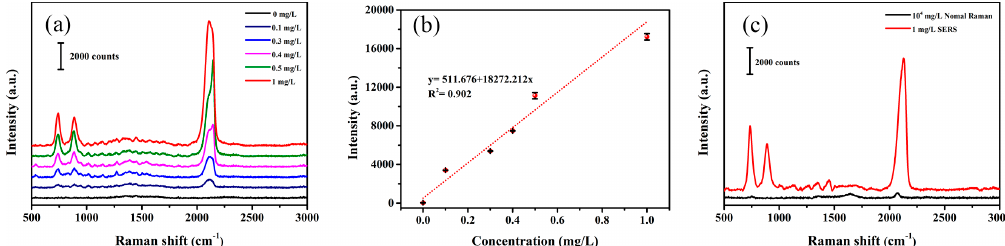
Figure 4. The SERS Detection of NaSCN in an aqueous solution (repeated three times). ( a ) The SERS spectra of NaSCN aqueous solution with different concentrations. ( b ) The relation curve between the intensity of SERS at 2126 cm − 1 and the concentration of NaSCN. ( c ) The SERS spectrum of 1 mg/L NaSCN aqueous solution and conventional Raman spectrum of 10 4 mg/L NaSCN aqueous solution.